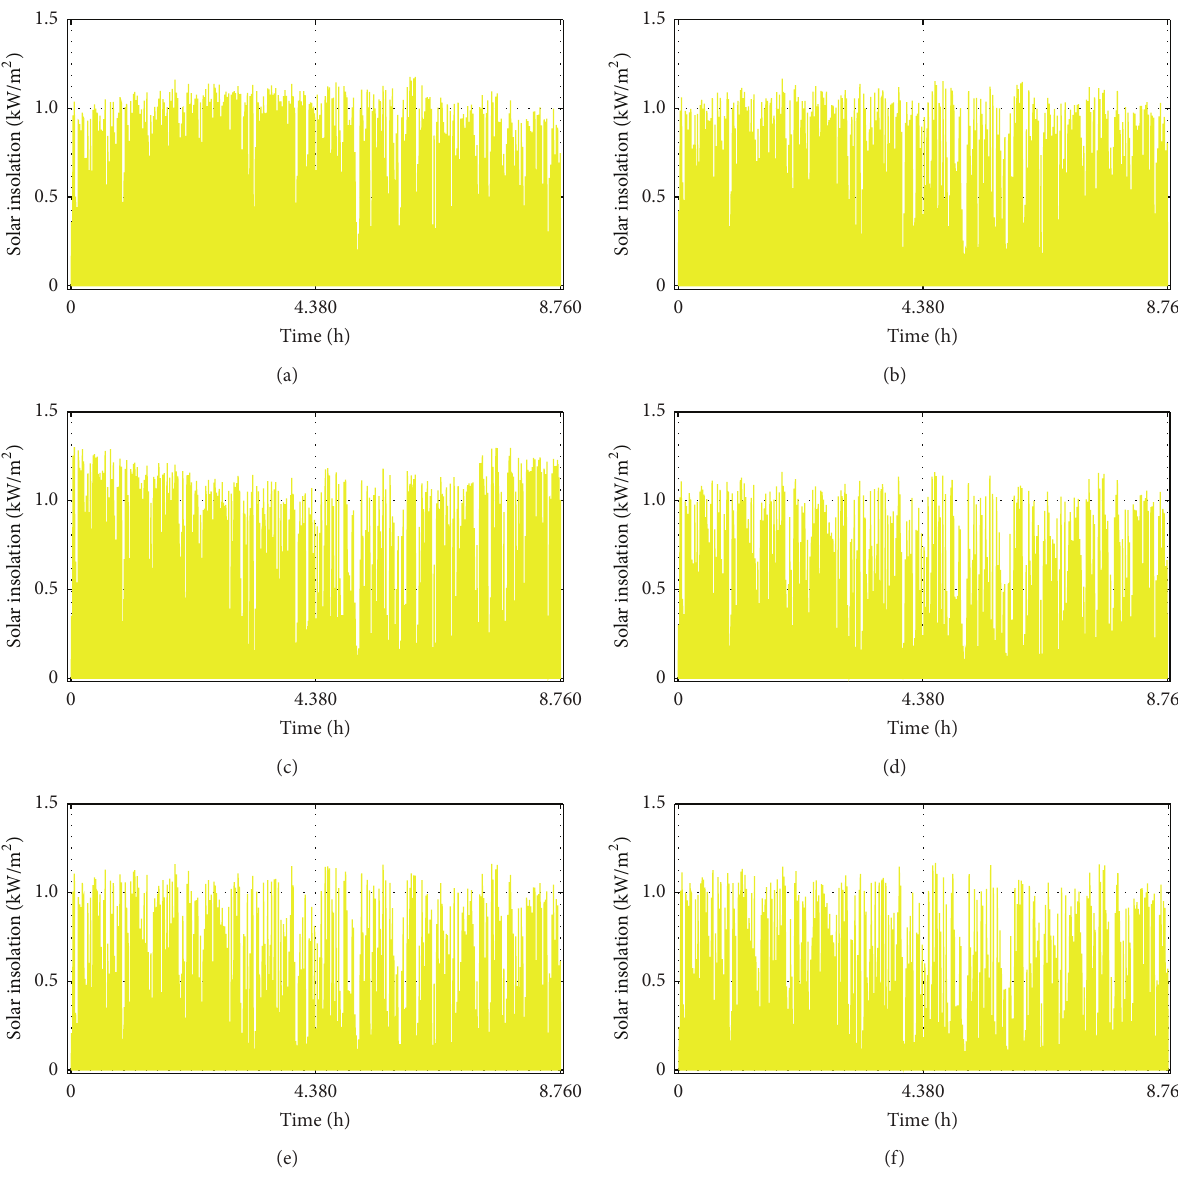
Figure 4: Computed hourly solar radiation on tilted PV surface using 22-year monthly average daily solar radiation data [16] for (a) Katsina, (b) Yola, (c) Abuja, (d) Nsukka, (e) Lagos, and (f) Benin City,